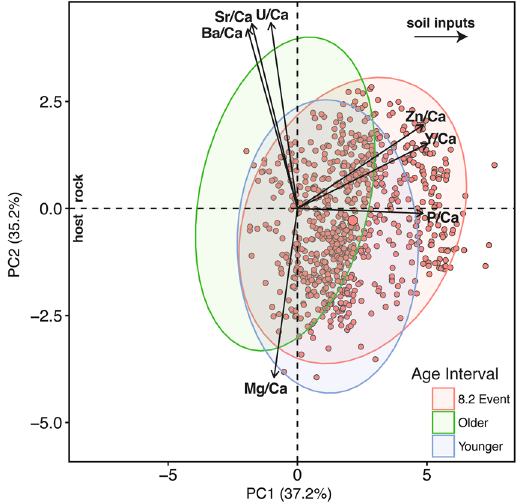
Figure 4. Principle components analysis of trace element variations in WMC1 showing PC1 and PC2. Results were log-transformed prior to analysis to account for non-normal distributions. 95% confidence ellipses are shown for the points that are older, younger, and coeval with the 8.2 ka event (~8250–8100 cal yr. BP). For simplicity, only points coeval with the 8.2 ka event are